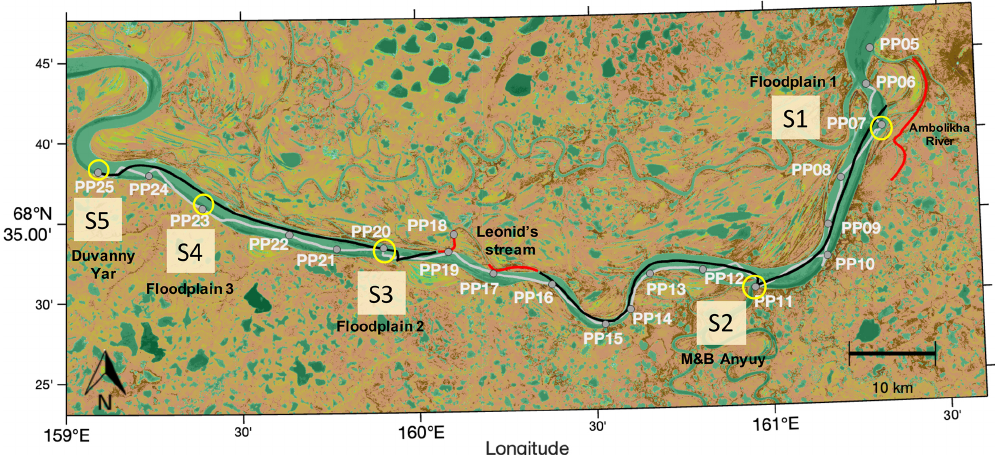
Figure 1. Navigated transects in the Kolyma River: upstream (UP) (grey line, sampled between 15 June 2019 at 12:30LT and 16 June 2019 at 16:59LT) and downstream (DOWN) (black line, navigated between 16 June 2019 at 17:00LT and 17 June 2019 at 13:30LT). Gaps in the continuous UP and DOWN transects are data not considered for the analysis because they involved navigation outside the main river channel (i.e., transects at Leonid’s stream and the Ambolikha River indicated in red). Discrete samples were collected at 21 sampling stations (PP05–PP25) during the UP transect (grey markers). Key sites (and stations): S1 (PP07), S2 (PP11), S3 (PP20), S4 (PP23), and S5 (PP25) are circled in yellow. This map was created using MATLAB ® with data from a composite image for June, July, and August from 2015–2018 using Sentinel-2 NDVI maps (https://developers.google.com/earth-engine/datasets/catalog/sentinel, last access: 15 May